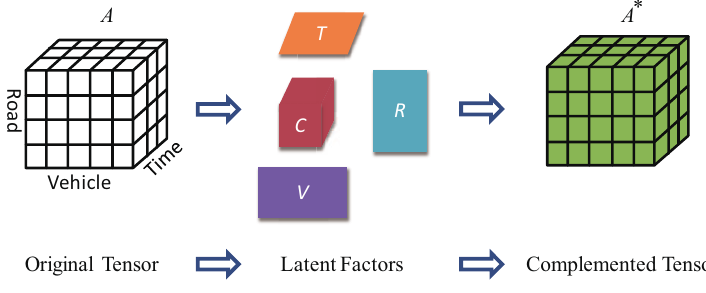
Figure 6. Tensor